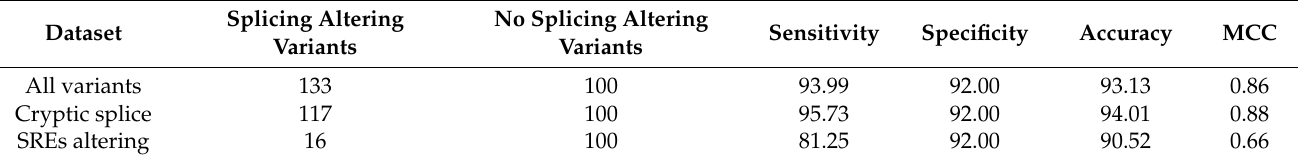
Table 1. Performance of SpliceAI for literature database with 233 deep intronic variants using the optimized threshold of